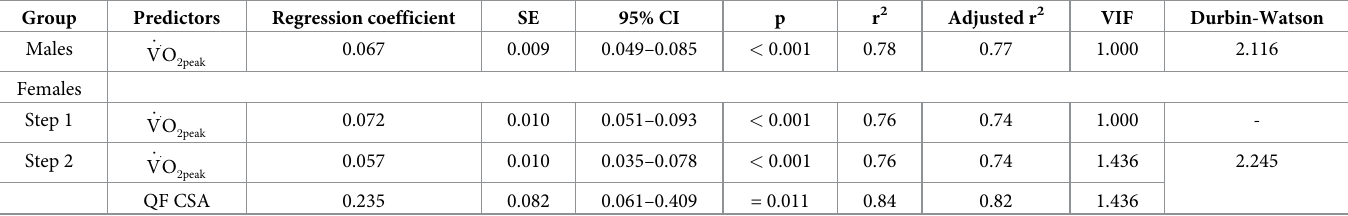
Table 3. Stepwise multiple regression analysis.